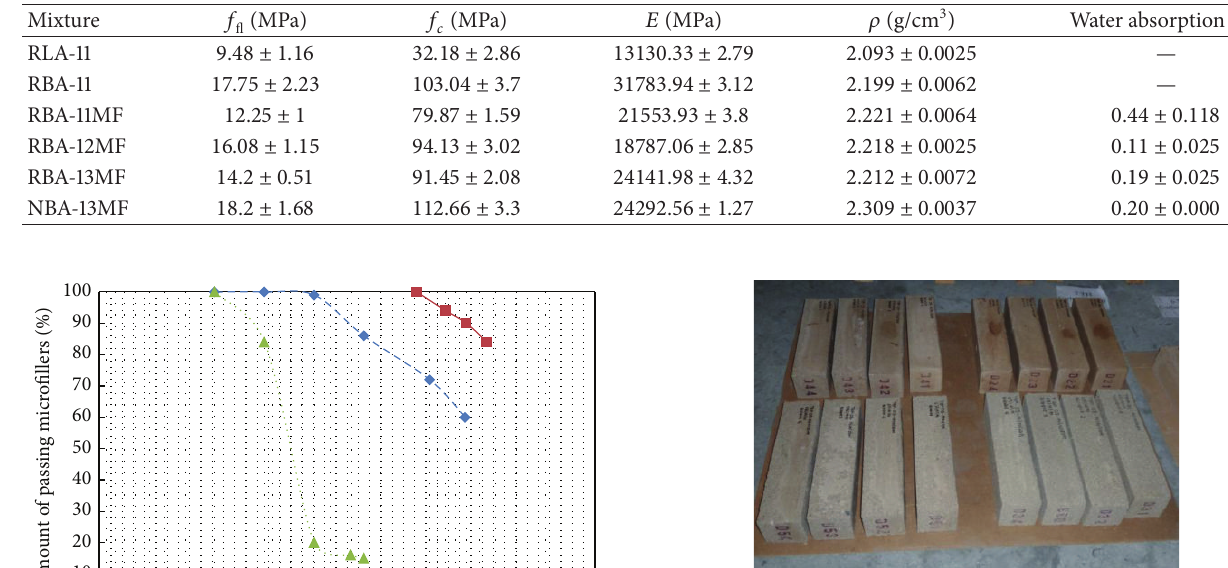
Table 4: Test results: mechanical properties, density, and water absorption (and standard deviation for each mean value).